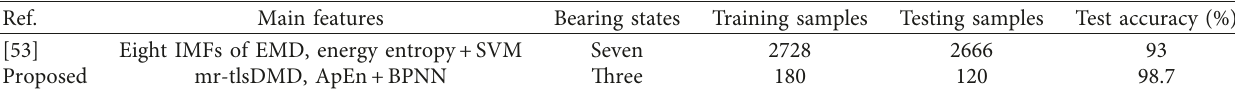
Table 10: Classification comparisons of NASA database-adopted mode decomposition algorithm. Ref.